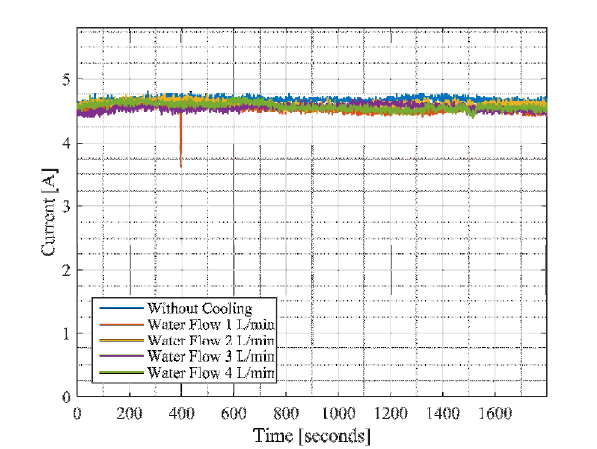
Fig. 8. Effect of water flow rate in the current produced.